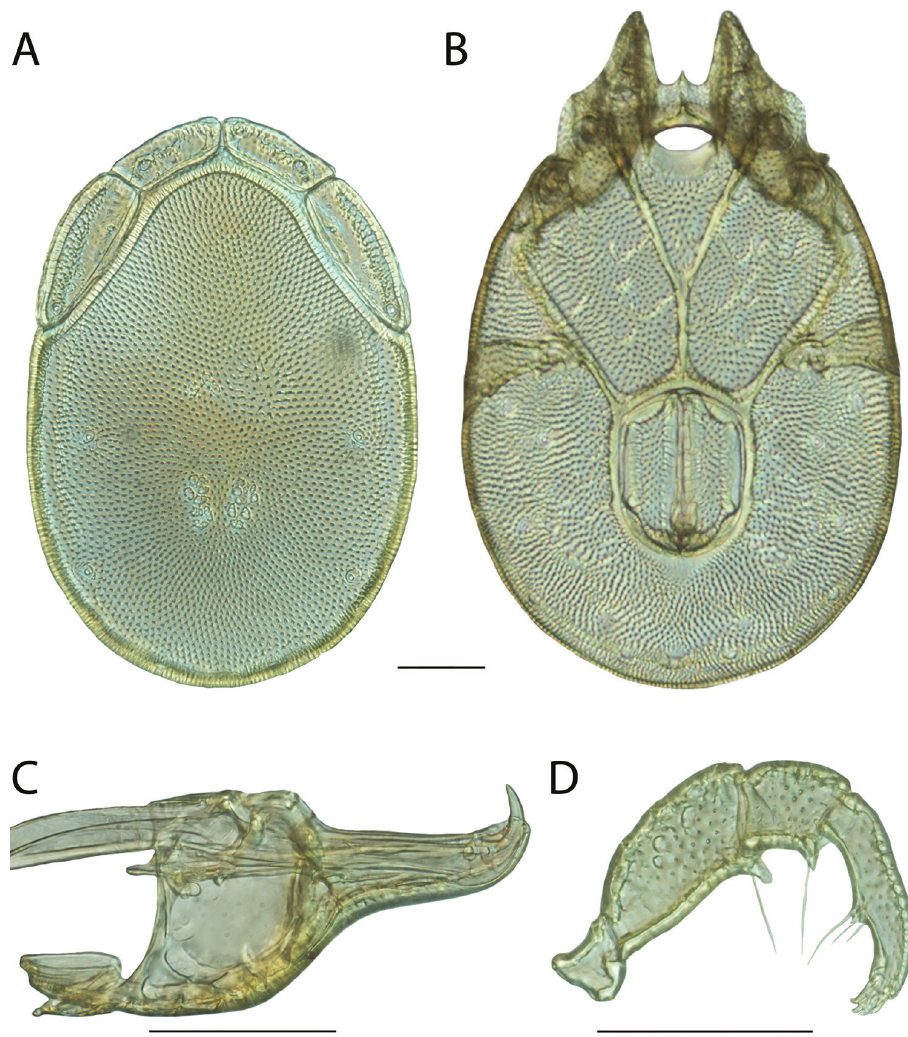
Figure 235. Torrenticola sharkeyi sp. n. female: A dorsal plates B venter (legs removed) C subcapitulum D pedipalp (setae not accurately depicted). Scale = 100